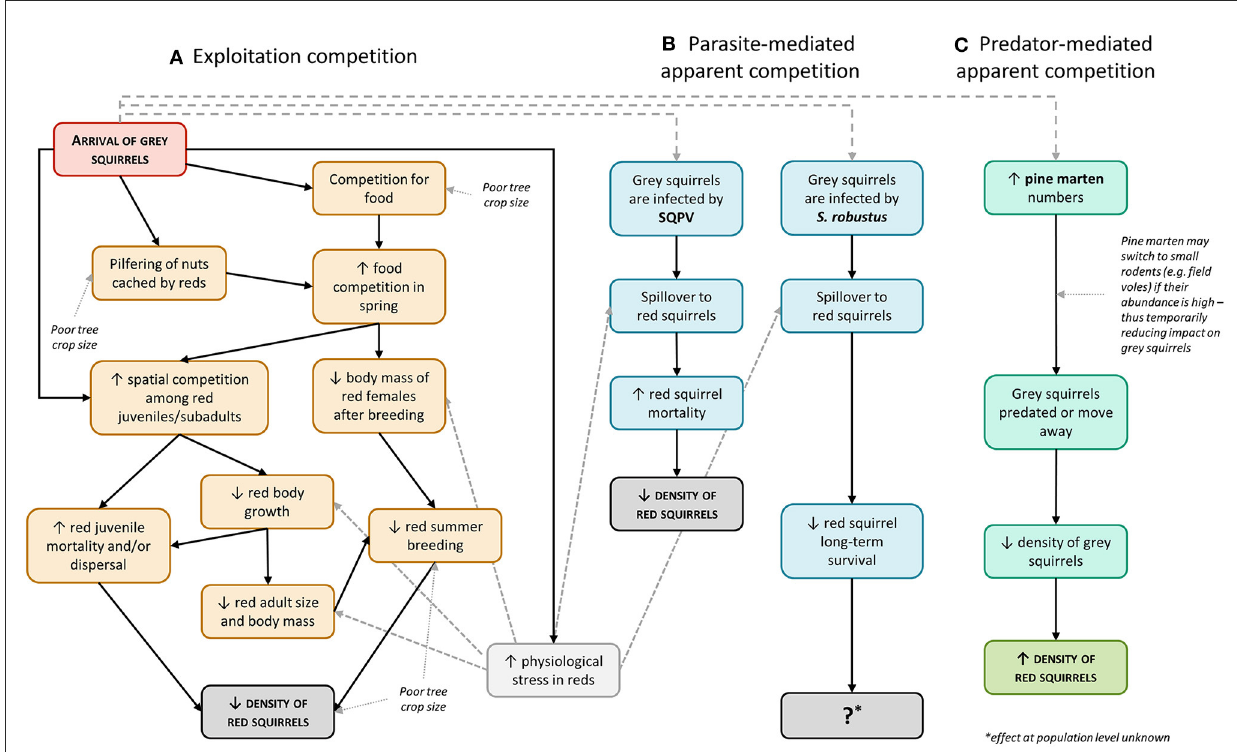
FIGURE2 Principal potential pathways of the mechanisms and the factors influencing the interspecific competition between red and gray squirrels (modified and expanded from Gurnell et al., 2015a). Solid lines indicate cause-effect relationships; dotted lines indicate external factors that may influence such relationships. Big-dashed lines indicate that the arrival of gray squirrels can potentially induce parasite- or predator-mediated apparent competition. Gray squirrels may not be infected with either SQPV or S. robustus . The effects of predator-mediated competition do not apply to urban areas and an abundance of small rodents such as voles and mice may provide a temporal refuge for both squirrel species as pine martens switch to feeding on these species (Slade et al., 2022b). Finally, small-dashed lines indicate where physiological stress may influence juvenile body growth and/or body condition of adults and contribute to increase the effects of parasites on red squirrel